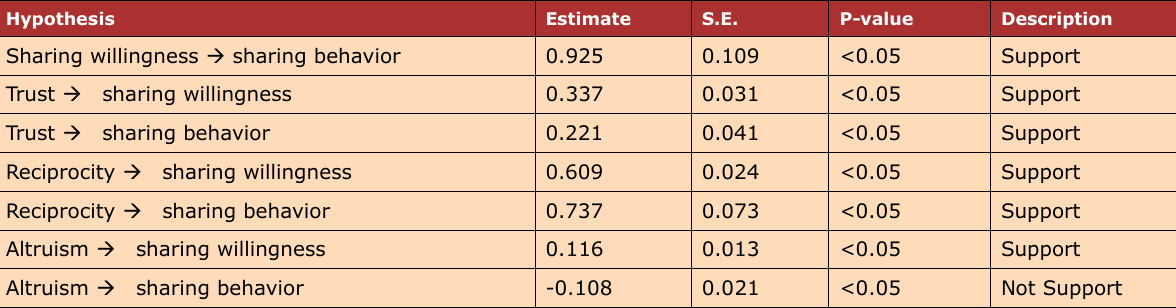
Table 5. Result of hypotheses